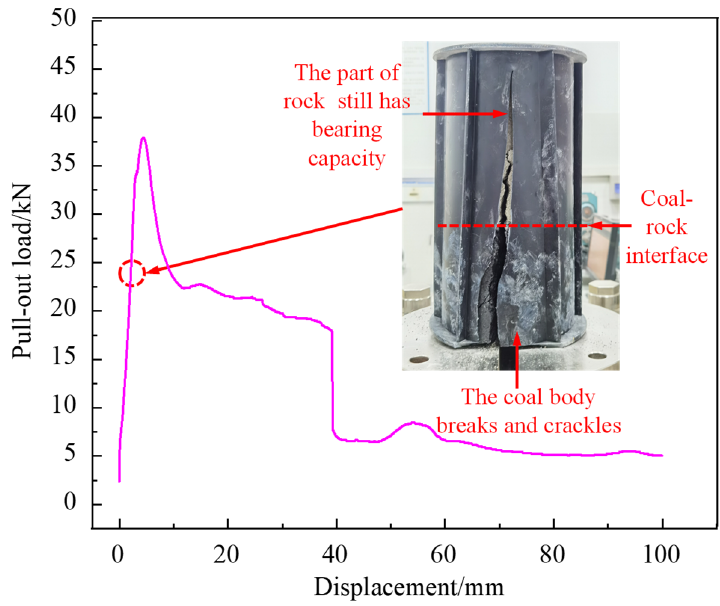
Figure 11. Time differential development of cracks on the coal–rock combined anchorage body.